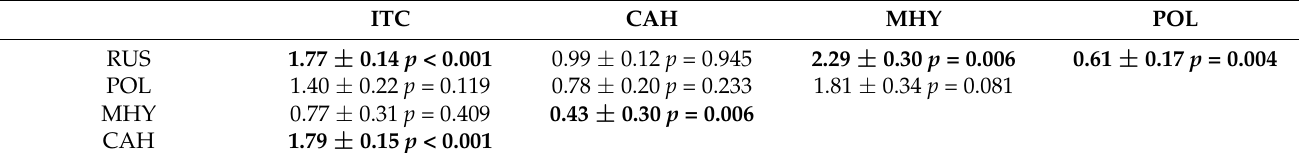
Table 2. Hazard ratio ( ± S.E.) for worker survival of IAPV inoculation relative to survival of sham-treated workers for the stock on the top of each column relative to the stock on the left of each row. Significant differences based on uncorrected significant thresholds are typed in bold-face.